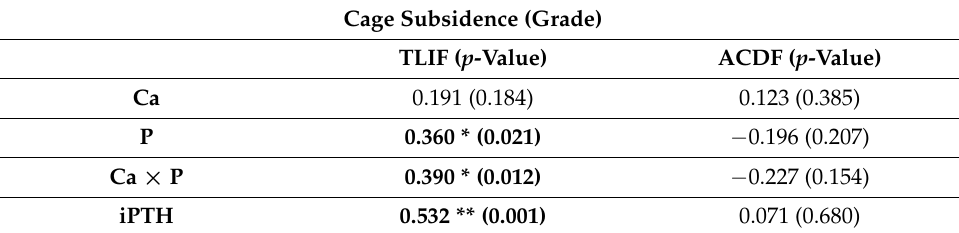
Table 3. Correlation between grade of cage subsidence and serum level of Ca, P, Ca × P, and iPTH in TLIF and ACDF